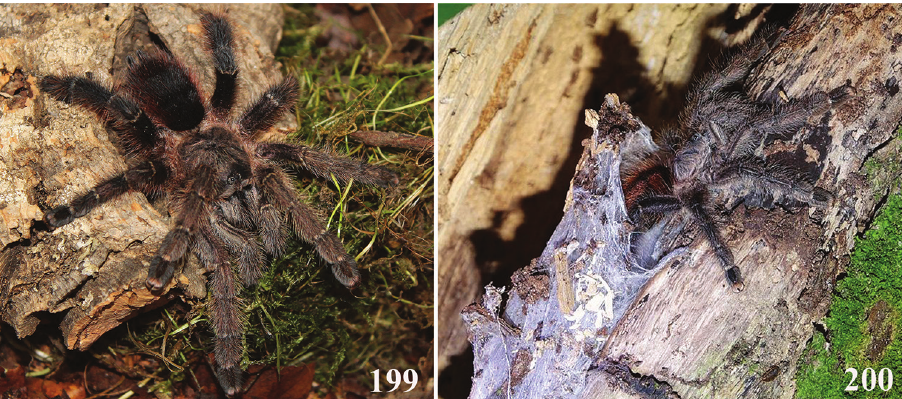
As in male, except: Carapace: 1.11 times longer than wide. Fovea: slightly recurve, 1.77 wide. Eyes: eye tubercle 0.70 high, 2.07 long, 2.91 wide. Clypeus 0.30. Eye size and interdistances: AME 0.72, ALE 0.70, PME 0.28, PLE 0.55, AME–AME 0.50, AME– ALE 0.47, AME–PME 0.19, ALE–ALE 2.03, ALE–PME 0.71, PME–PME 1.64, PME–PLE 0.16, PLE–PLE 2.11, ALE–PLE 0.49, AME–PLE 0.52. Maxilla: length to width: 2.02. Labium: 1.77 long, 2.41 wide, with 96 cuspules spaced by one diameter from each other, on anterior half. Chelicera: basal segment with 9 teeth and some small teeth on promargin. Ster- num: 7.17 long, 5.92 wide. Legs: Length leg IV to leg I: 1.09 Clavate trichobothria: on distal 1/2 tarsi I–IV. Scopula: Tarsus IV with sparse setae. Metatarsi II fully scopulate; III 1/2, IV 1/3 distal scopulate.